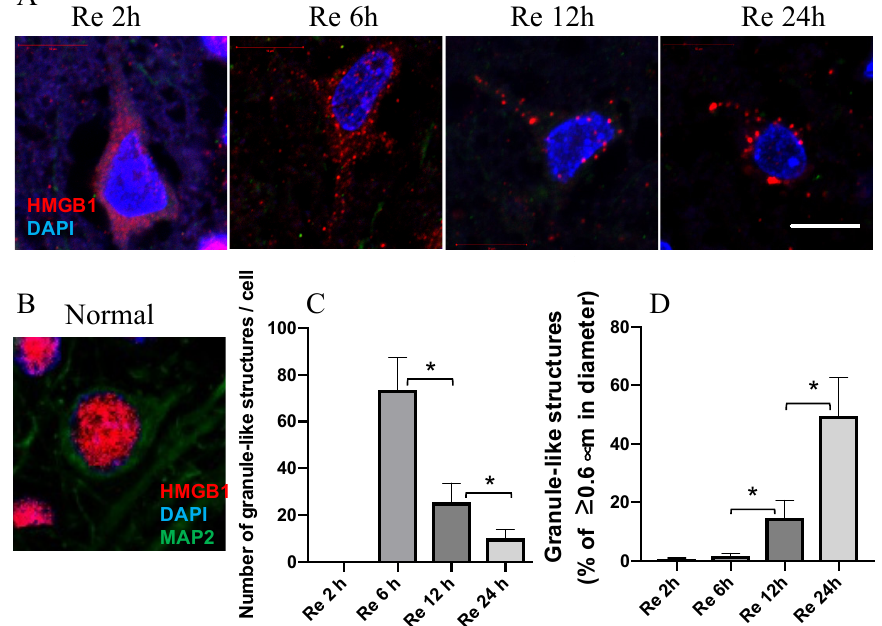
Figure 1. HMGB1 translocation at the indicated time intervals. ( A ) HMGB1 staining in a typical neuron in the parietal cortex at 2, 6, 12, and 24 h after reperfusion of MCAO. ( B ) HMGB1 staining in a typical neuron of cortex in normal rat brain. ( C ) The number of granule-like structures with the diameter more than 0.3 µ m per cell in the cytosol at the indicated time intervals after reperfusion of MCAO. ( D ) The ratios of the number of granule-like structures with more than 0.6 µ m in diameter vs. total number of granule-like structures in the cytosol were determined at the indicated time intervals after reperfusion of MCAO. Scale bar: 10 µ m. ( n = 6, * p < 0.05)